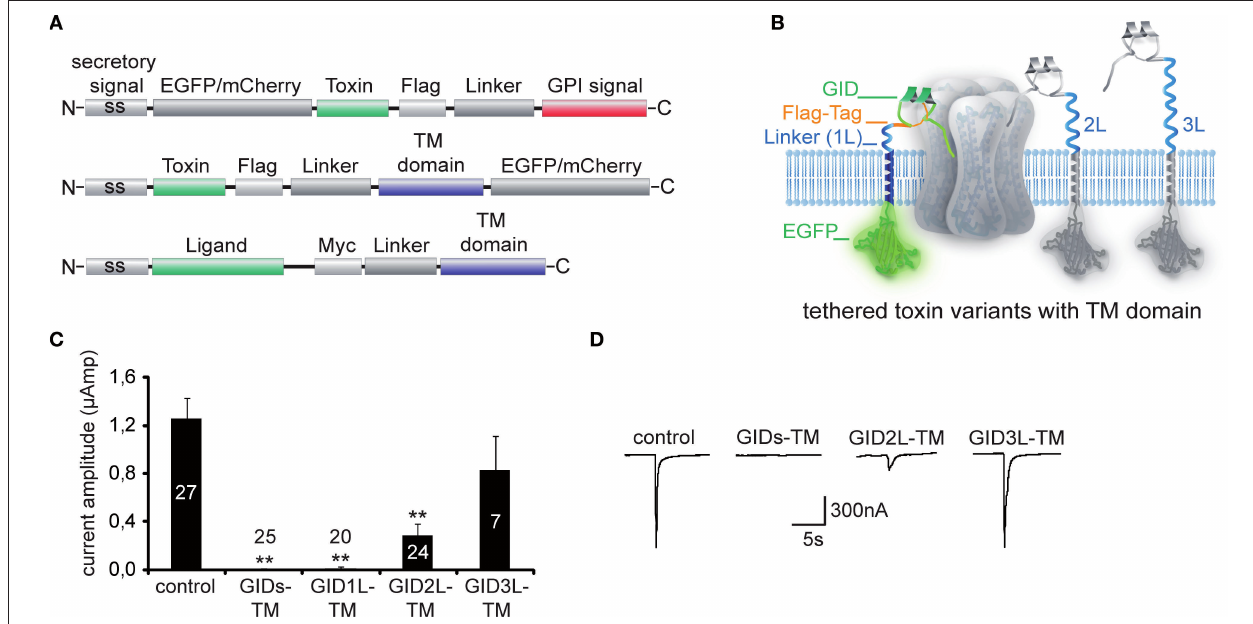
FIGURE 2 | Modular architecture of membrane-tethered toxin and ligand peptides. (A) Illustration of tethered-peptide variants consisting of secretory pathway signal sequence (ss), toxin/ligand cassettes, fl uorescence markers (EGFP or mCherry), epitopes for immunostaining (Flag-tag, Myc-tag), fl exible linker regions, and distinct functional modules for membrane attachment (GPI- signal, transmembrane-domain TM). (B) Illustration of t-toxin carrying the nAChR-specifi c snail-toxin GID with varying linker lengths [short (s), 1L, 2L and 3L]. (C) Electrophysiological recordings in Xenopus laevis oocytes expressing α